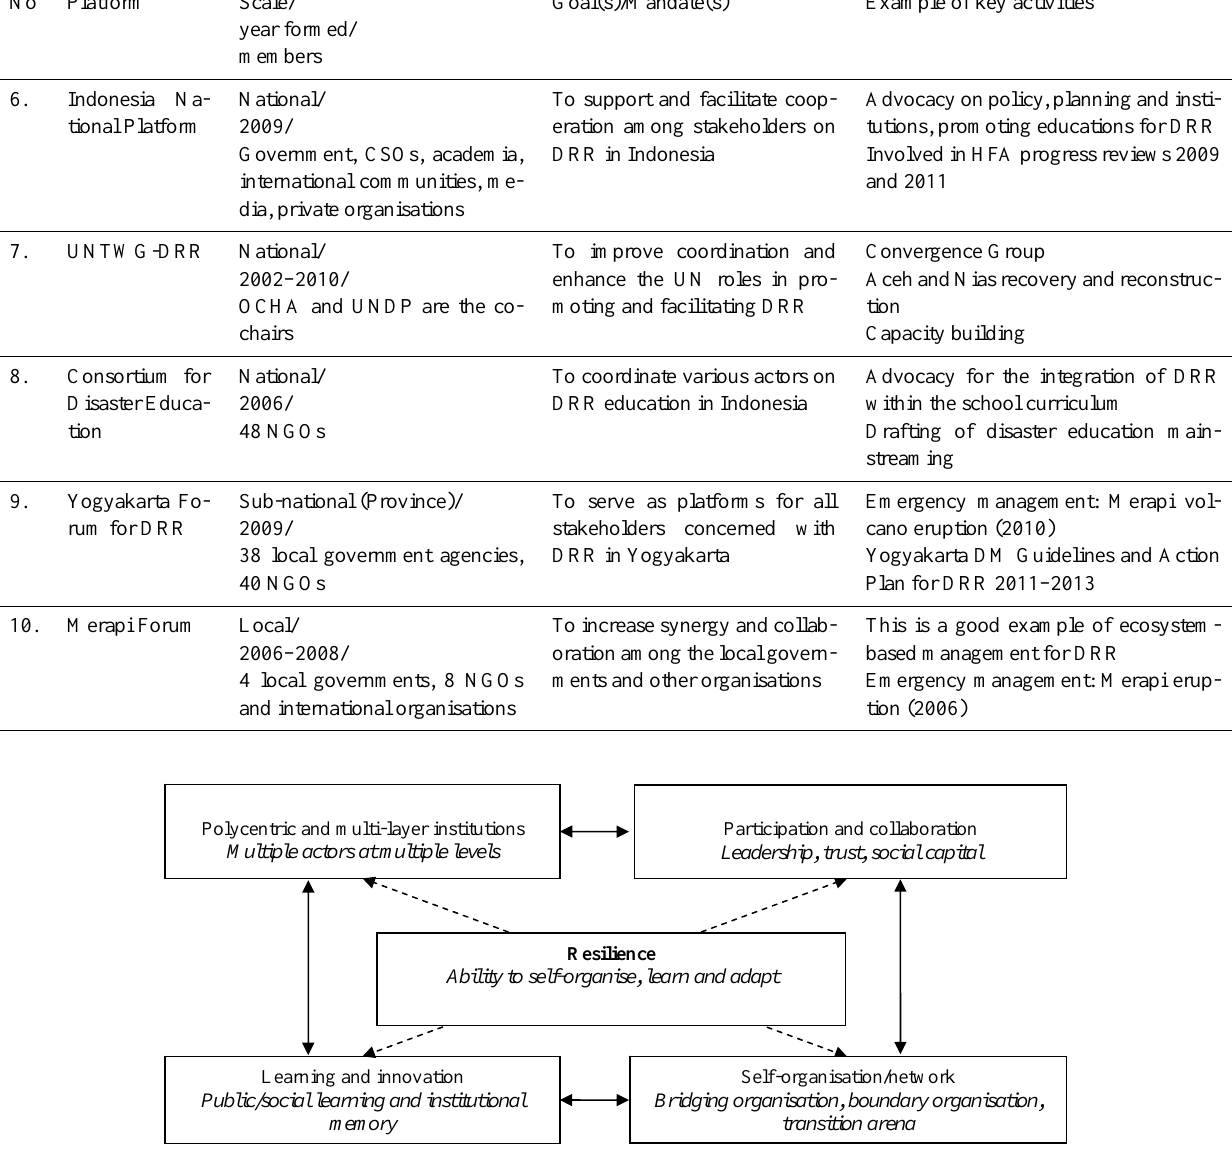
Figure 1: Relationships between adaptive governance and resilience (Source: Djalante et al., 2011) 1 . 237 The following sub-sections interrogate the MSPs in rela- tion to each of the four characteristics to help answer the first question of the paper on how MSPs are formed, organised and coordinated. Each sub-section systematically discusses the MSPs from a global, regional, national and local level.